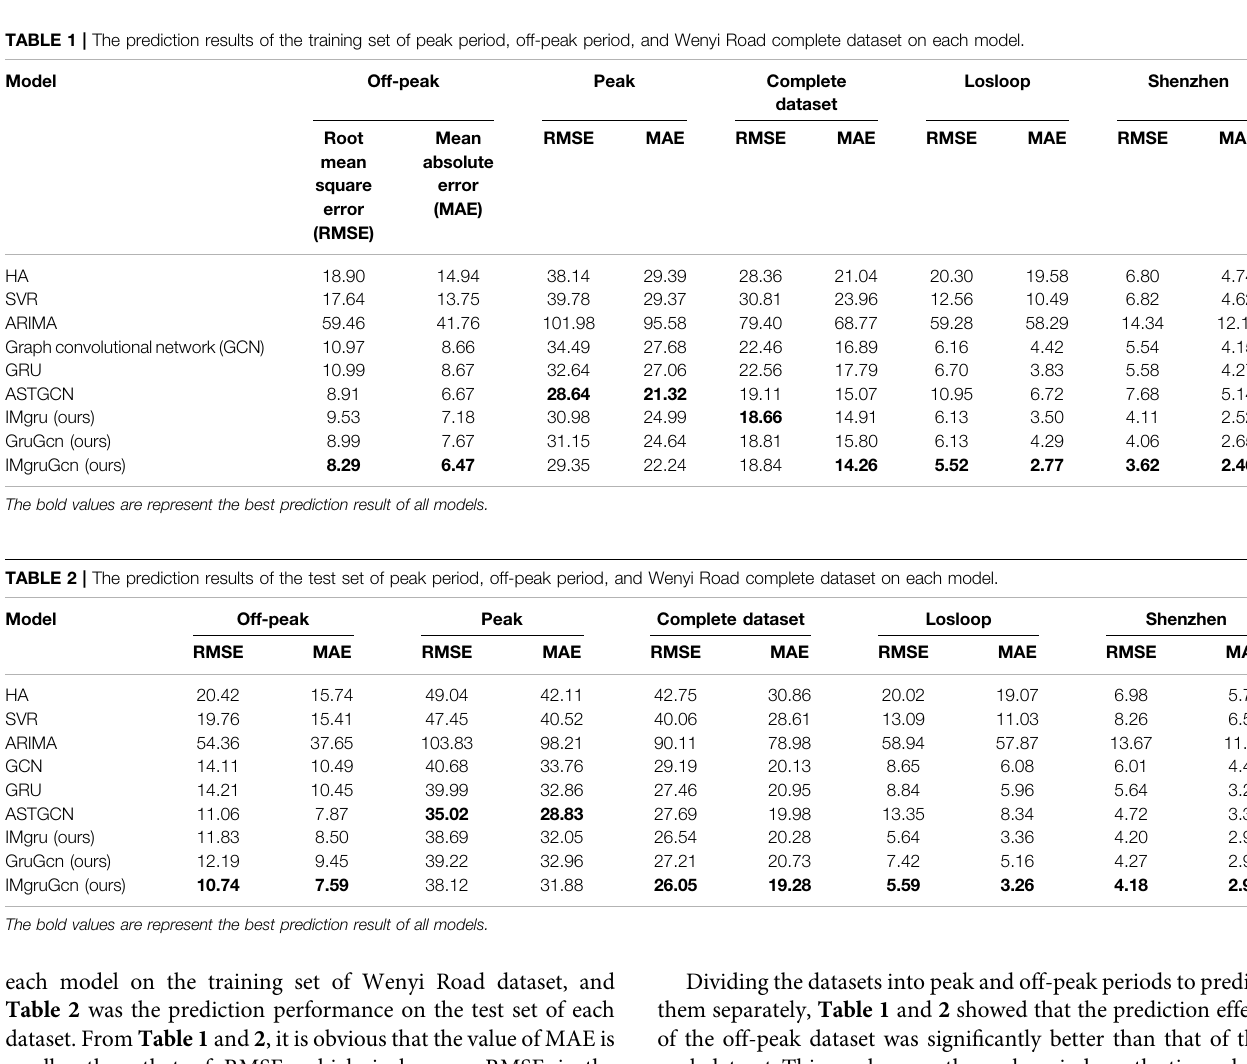
TABLE 1 | The prediction results of the training set of peak period, off-peak period, and Wenyi Road complete dataset on each model. Model Off-peak Peak Complete